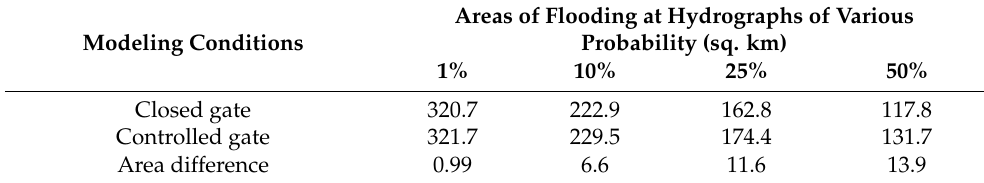
Table 5. Flooded areas according to design data at discharges of different probability.